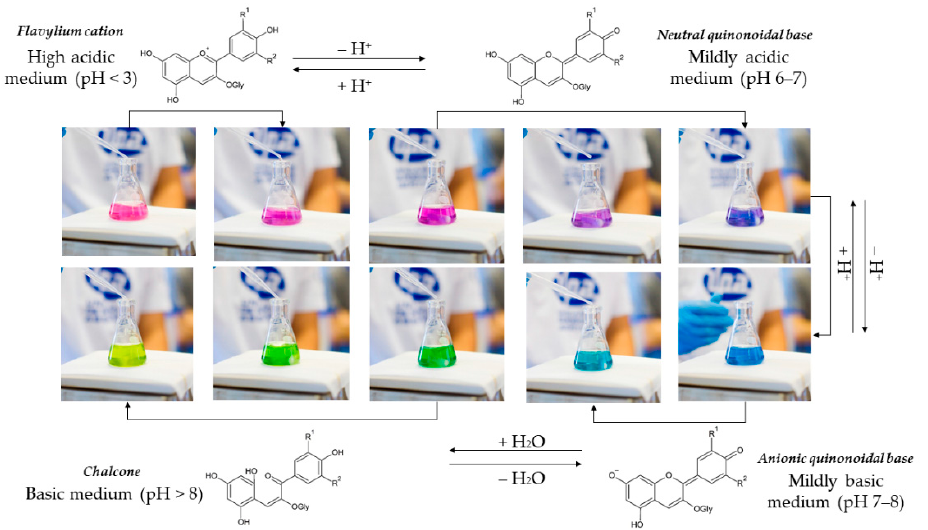
Figure 2. pH-dependent chemical structures and color changes of anthocyanins from red cabbage. Experiment performed by Gustavo Araujo Pereira and registered by Karla Ferreira Nery Martins (photos). HCl and NaOH (0.1 M) were employed to alter the pH of the red cabbage aqueous extract.